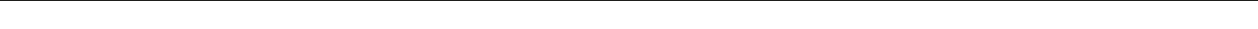
Fig. 1 An experimental system for the systematic interrogation of the effects of variation in the 3 ′ UTR sequence on protein repression. a A schematic representation of our massively parallel reporter assay (Methods). b MiRNAs expressed in K562 cells as quanti fi ed by a published microarray experiment 34 . The ten highly expressed miRNAs selected for the library design are indicated. c An illustration of the four binding site types used for the design of MREs complementary to the ten selected miRNAs. MRE sequences were designed to match the depicted structure using ViennaRNA 2.0 60 . The perfect match MRE is a fully complementary binding site, disregarding the preference of the miRNA machinery for an “ A ” at the fi rst position. For all other binding site types, the fi rst position was forced to be an “ A ” . d An illustration of the four main mutagenesis schemes used in the design of the 3 ′ UTR sequences. First, we placed the designed MREs in a variety of native or designed contexts. Second, we subjected the MREs in the selected contexts to extensive mutagenesis of the binding sites. Third, we positioned multiple MREs in different architectures and compositions in selected contexts. Finally, we introduced mutations into native sequences that contained predicted MREs and included those in our library alongside the wild-type (WT) sequence. Different patterns depict different sequence contexts, while different colors depict different MREs. Designed mutations within the MRE sequence are annotated with an “ X ” and include single-base substitutions, single-base insertions, single- and double-base deletions, and cumulative mismatches from the MRE 5 ′ end. See also Supplementary Figure 1 and